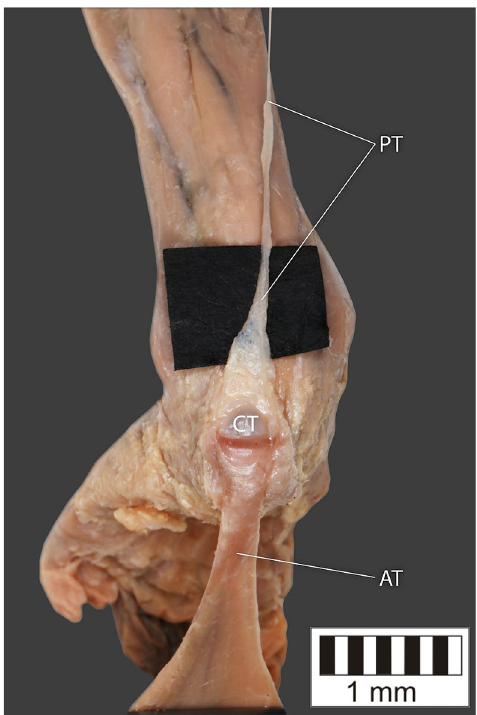
Figure 5. Type III of plantaris tendon. CT calcaneal tuberostity, AT Achilles tendon, PT plantaris tendon.